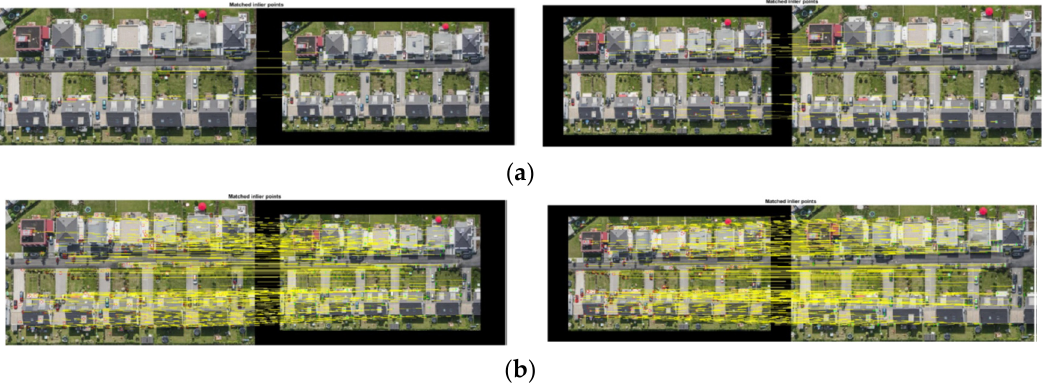
Figure 6. Matching result between the original image and the 0.8 and 1.2 scaled images using ( a ) SYnthetic BAsis (SYBA) and ( b ) robust SYBA (rSYBA).